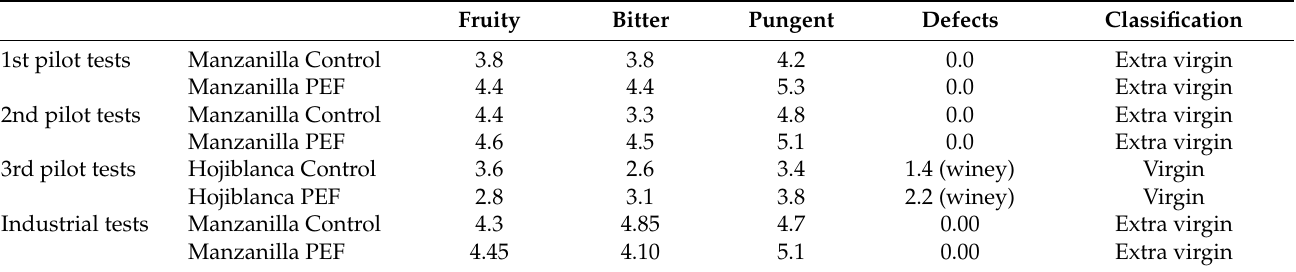
Table 4. Sensory evaluation of control and PEF oils obtained from ‘Manzanilla’ and ‘Hojiblanca’ cultivars.